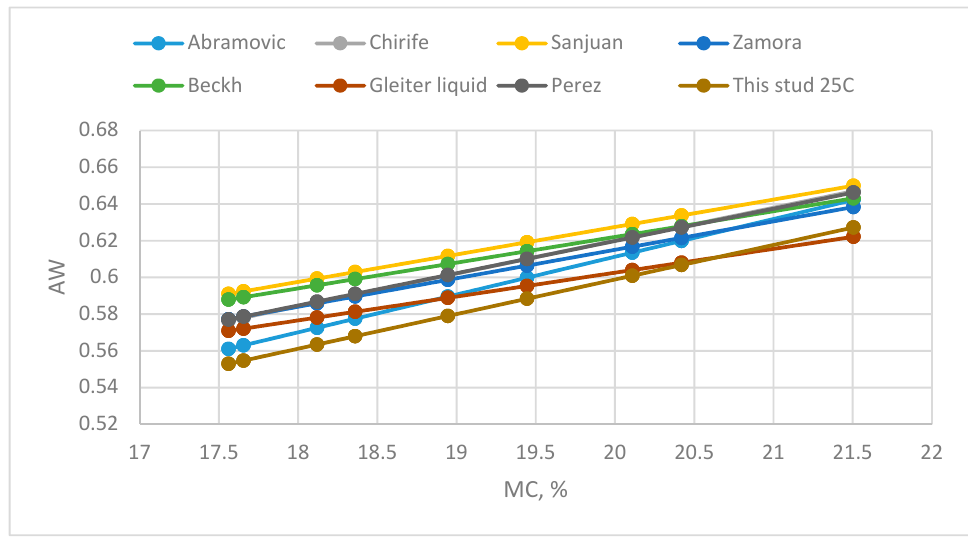
Figure 5. Comparison of Aw/MC equation at 25 °C with models from literature: [5,7,8,9,10,12,18].